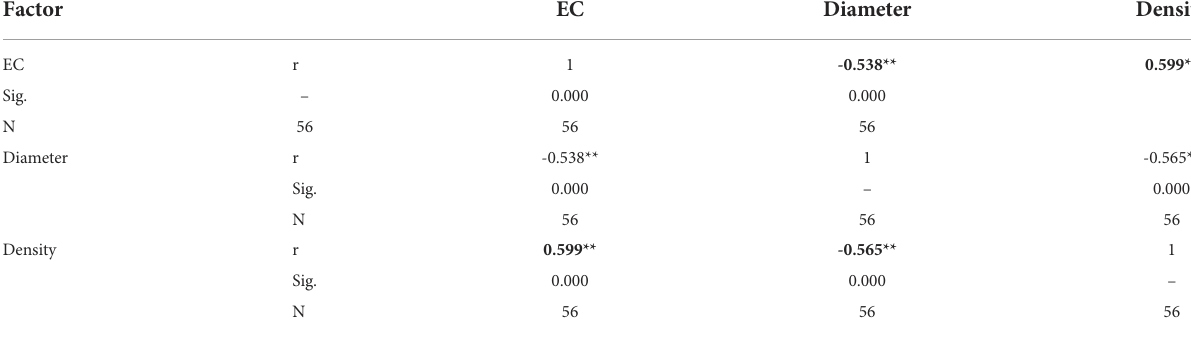
TABLE 2 Correlation between soil electrical conductivity and Phragmites australis diameter and density. Factor EC Diameter Density